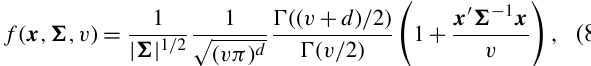
tal sample size) calculated from each component are taken as initial parameters for GMM, which are shown in Table